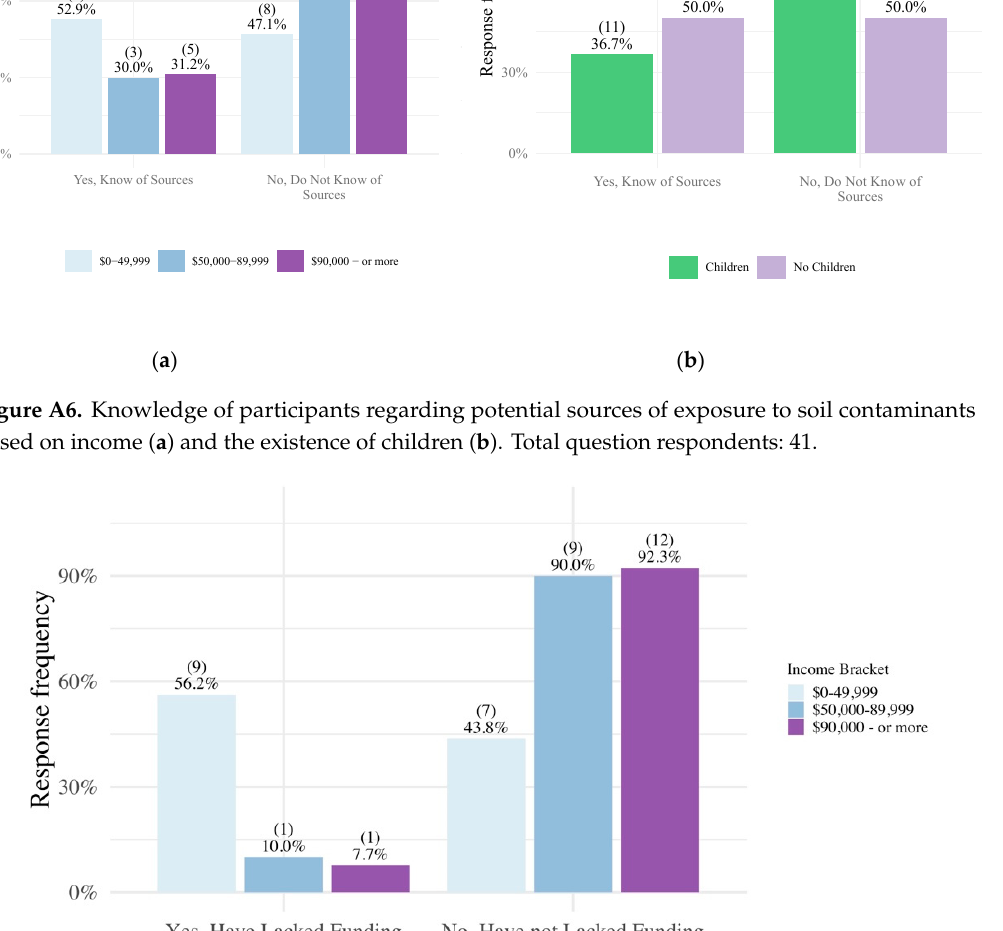
Figure A7. Respondents’ lack of funding to remediate heavy metal soil contaminants and/or slag by income levels. Total question respondents: 40